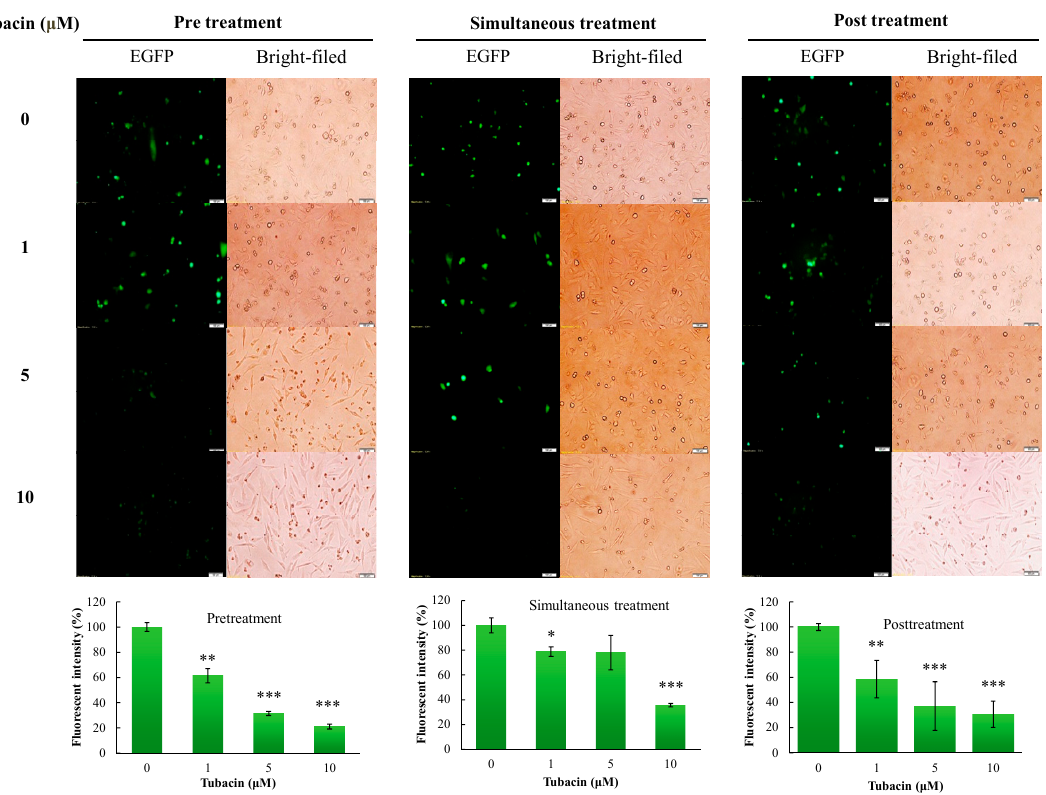
Figure 5. Time-of-addition assay for analyzing antiviral action of tubacin against JEV SRIPs. SRIP-infected cells were treated with tubacin 1 h prior (pre) ( left ), simultaneous ( middle ), or 1 h post ( right ) infection. Bright-field and fluorescence images of infected cells were taken 36 h post infection ( upper ). Green fluorescence intensity of SRIP-driven EGFP reporter in infected cells was quantified using Image J, and then relative intensity was normalized by the total of cells ( bottom ). * p value < 0.05; ** p value < 0.01; *** p value < 0.001 compared with untreated infected cells. Scale bar = 50 μ m.